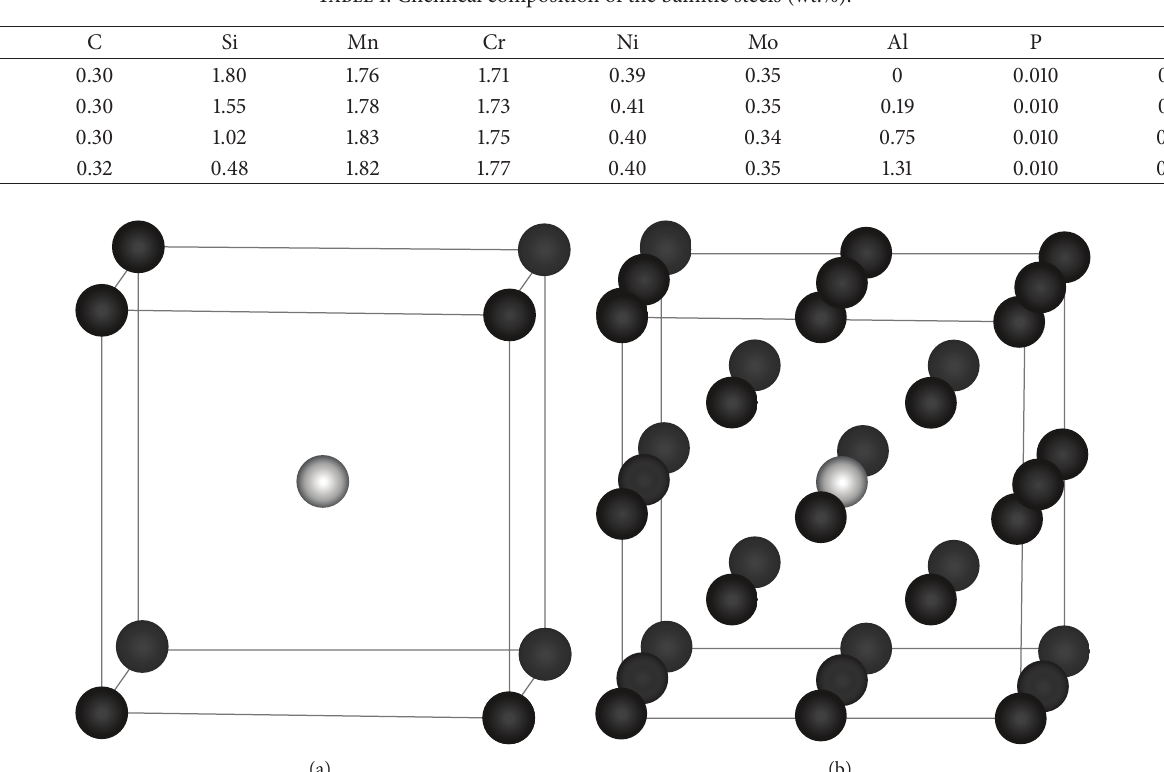
Figure 1: Schematic diagram of FeX (a) and Fe 15 X (b) (Fe black and X grey, X represents Al or